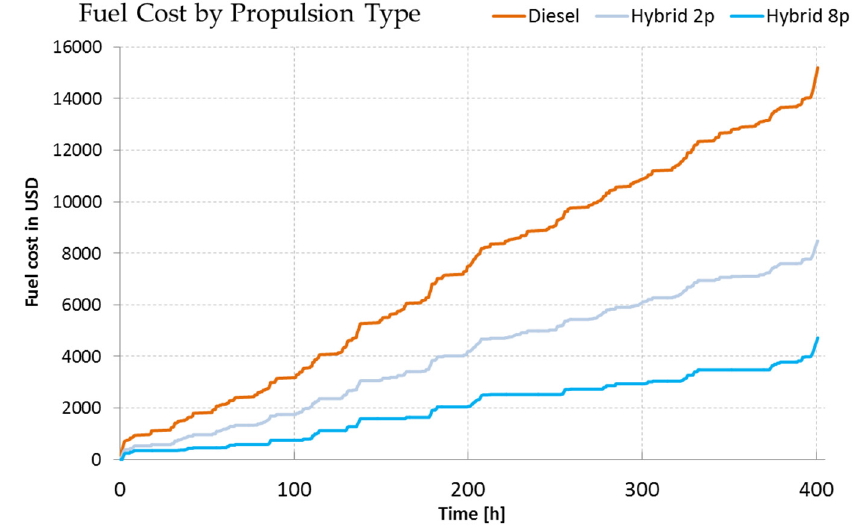
Figure 16. Plot of fuel cost by propulsion type on the same test route.